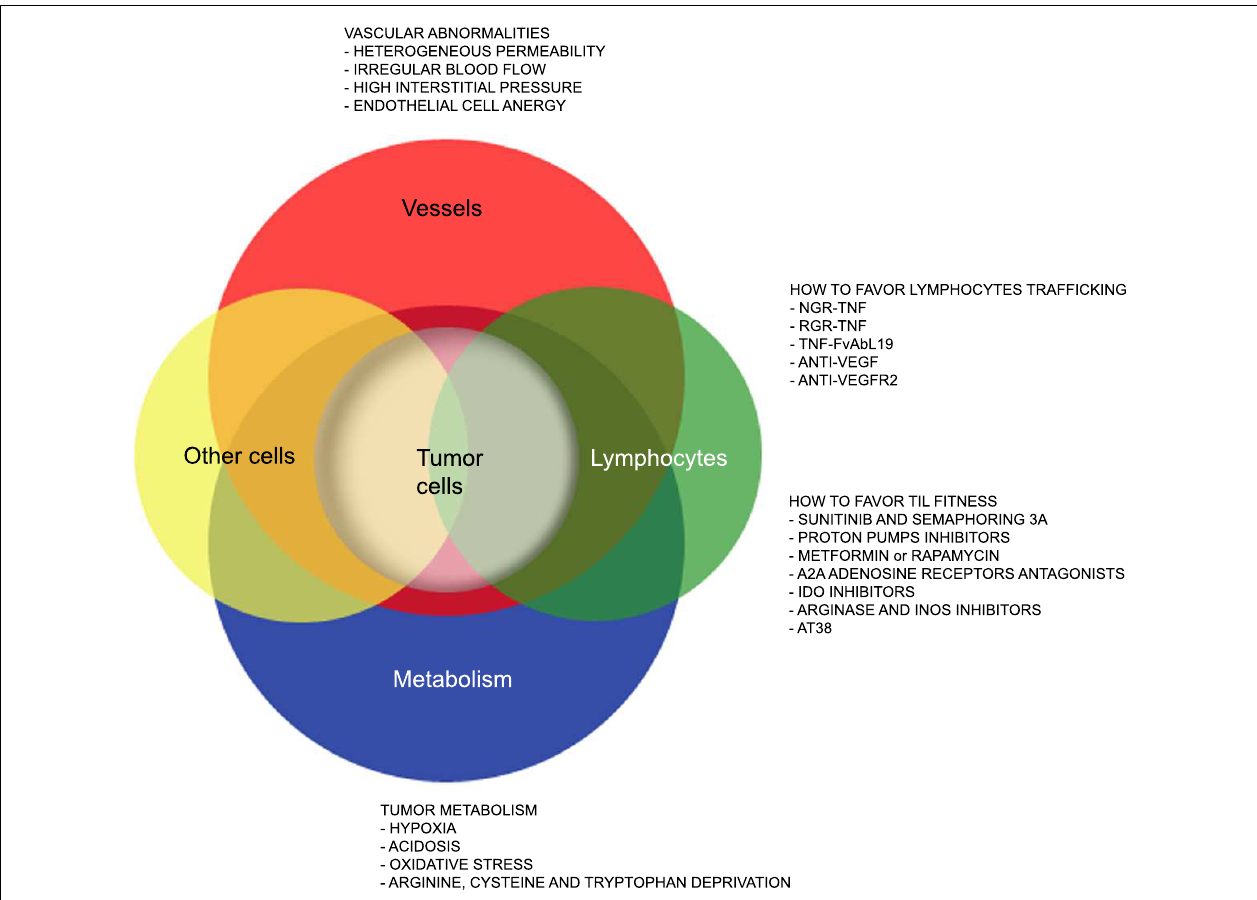
tumor microenvironment that limit lymphocyte trafficking into tumor and TIL anti-tumor activities. Strategies to overcome such hurdles are also